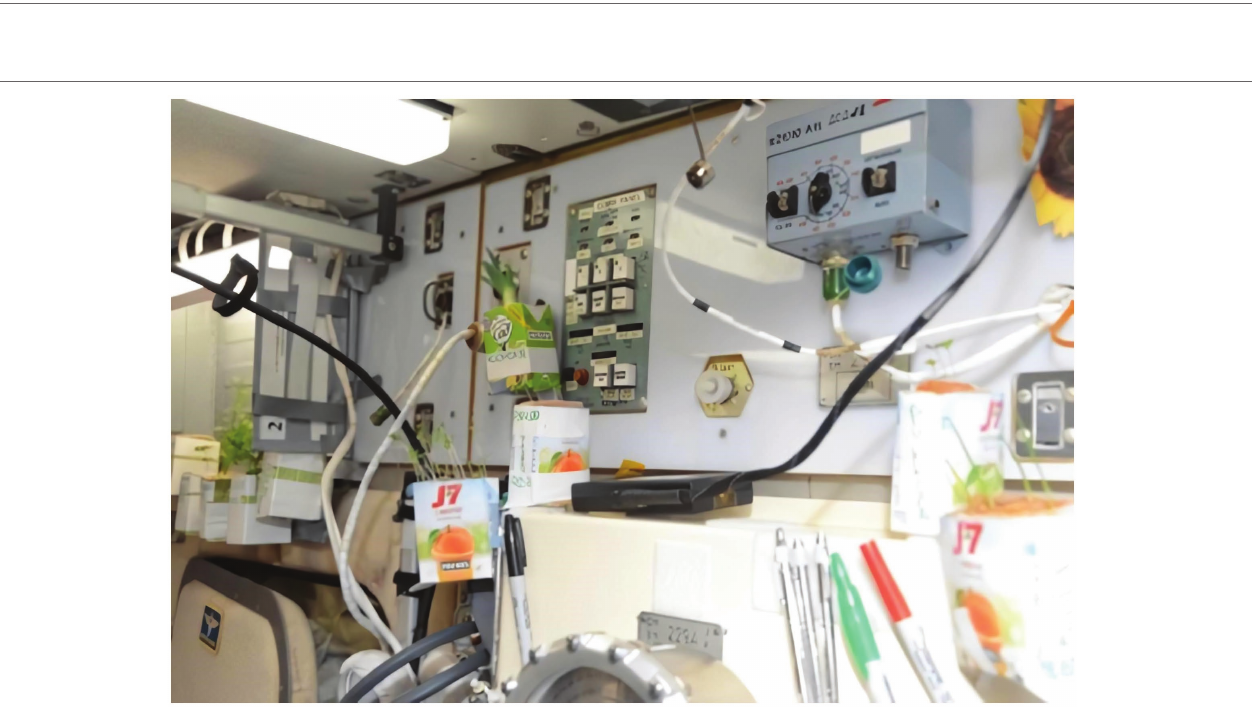
FIGURE 3 | A virtual personal space in the VR environment, developed by the IBMP specialists (together with the AI Health LCC) for psychological support in conditions of crowding and lack of privacy. Copyright by AI Health LCC and Ivan A. Rozanov, March